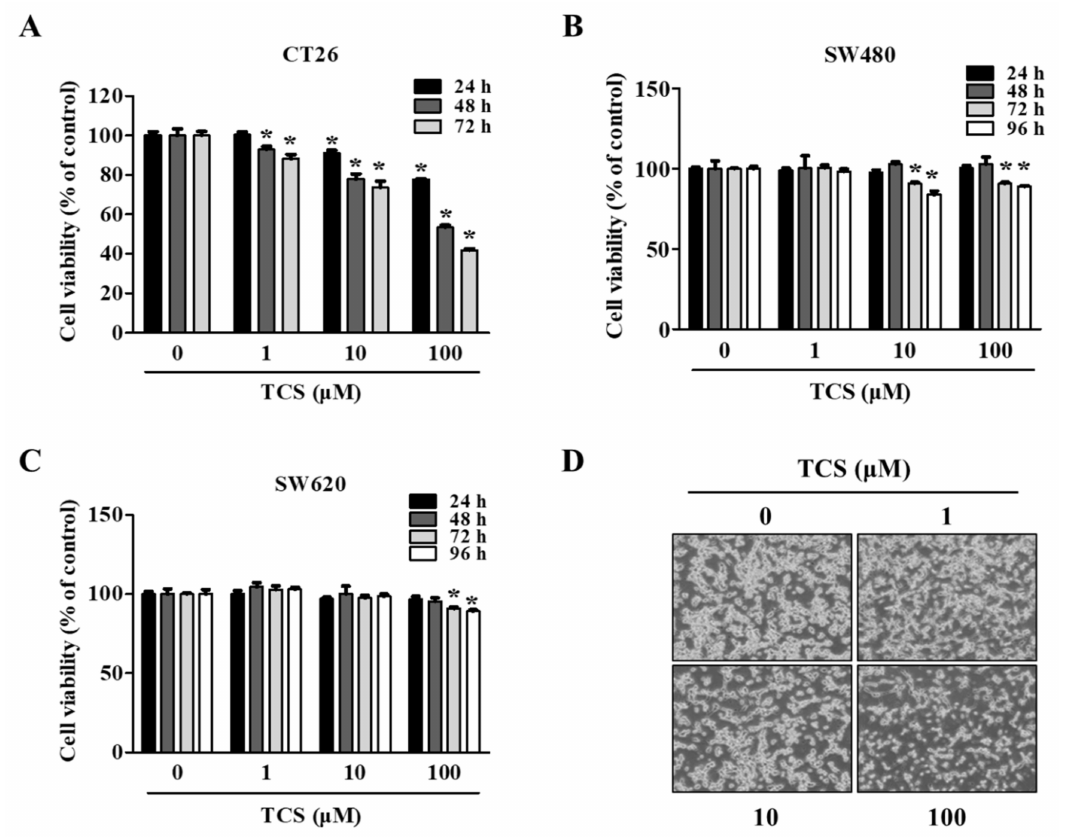
Figure 3. TCS decreases cell proliferation of colorectal cancer (CRC) cells. ( A – D ) Cell viability in CT26 ( A ), SW480 ( B ), and SW620 ( C ) on TCS treatment. Cells were seeded in 96-well plates and treated with TCS (1–100 µ M). After incubation, cell viability was determined by WST-1 assay. Data are expressed as the mean ± SD of three independent experiments. * p < 0.05. ( D ) Morphology of TCS-treated CT26 cells for 48